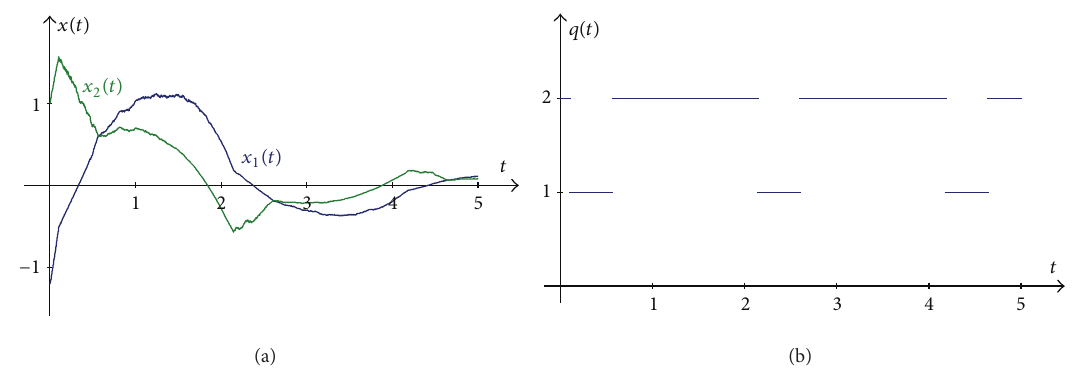
Figure 3: Stable path of the hybrid system (22) with stabilizing switching 𝜎